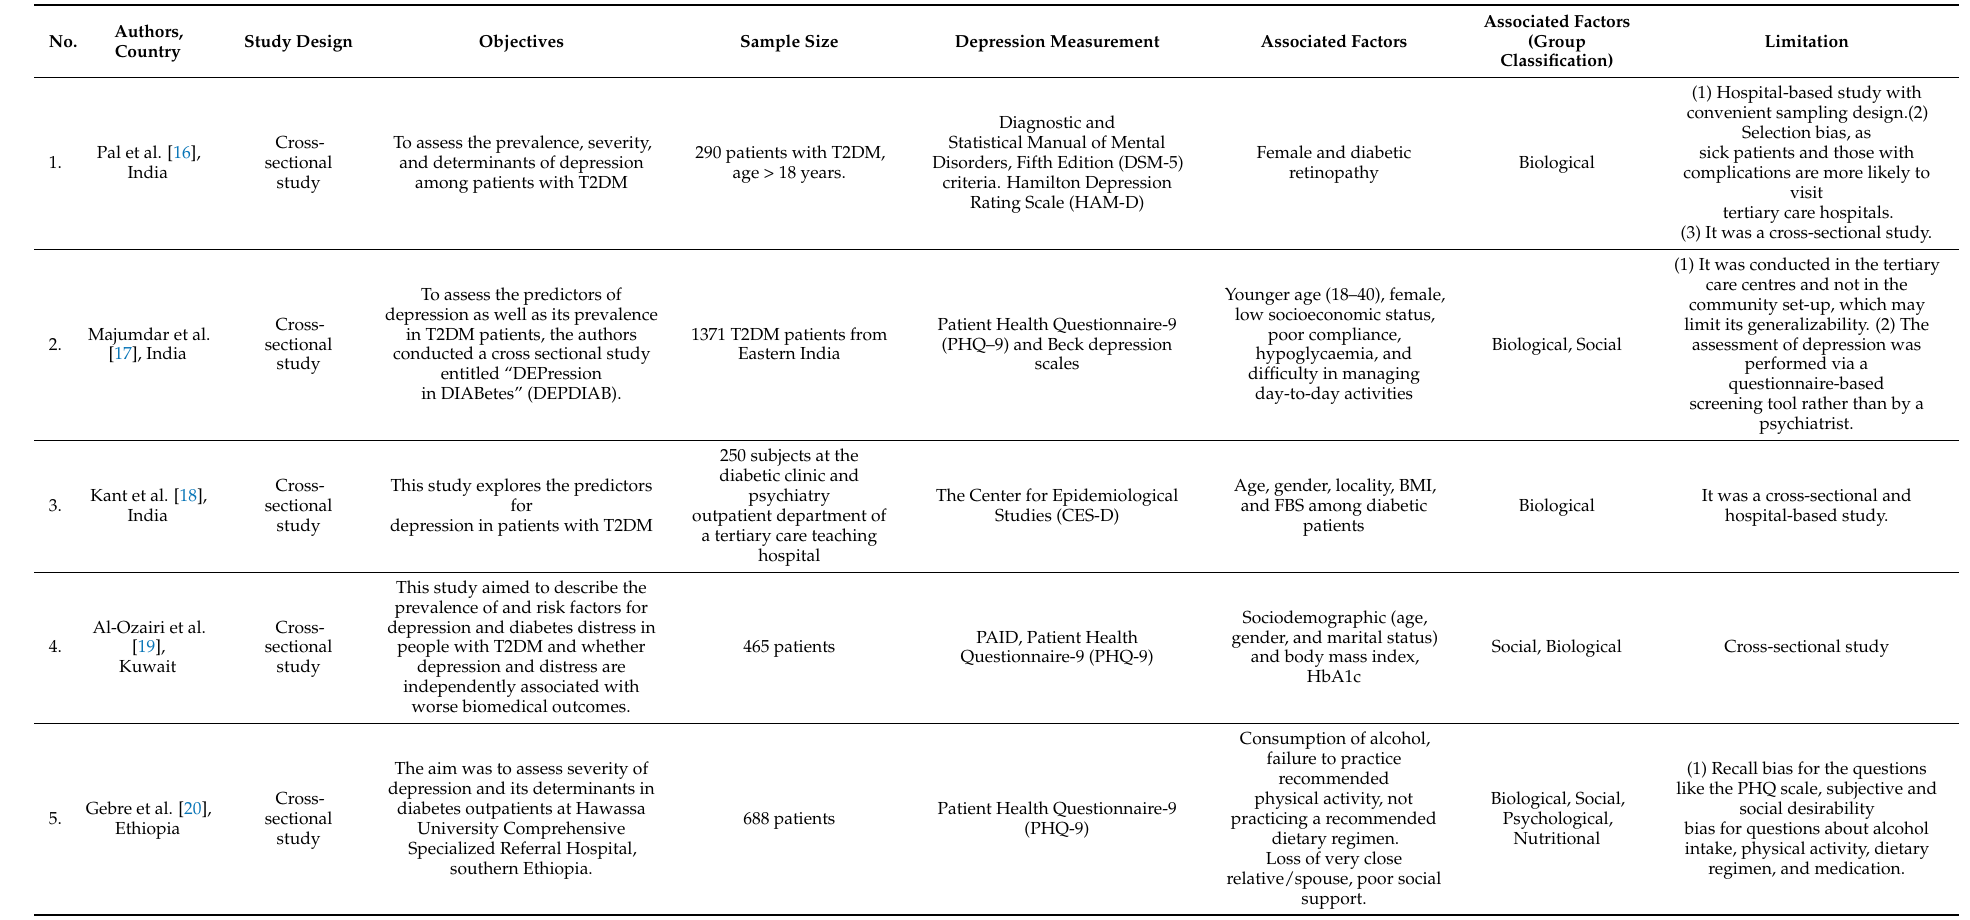
Table 2. The measurement of depression and its related factors among